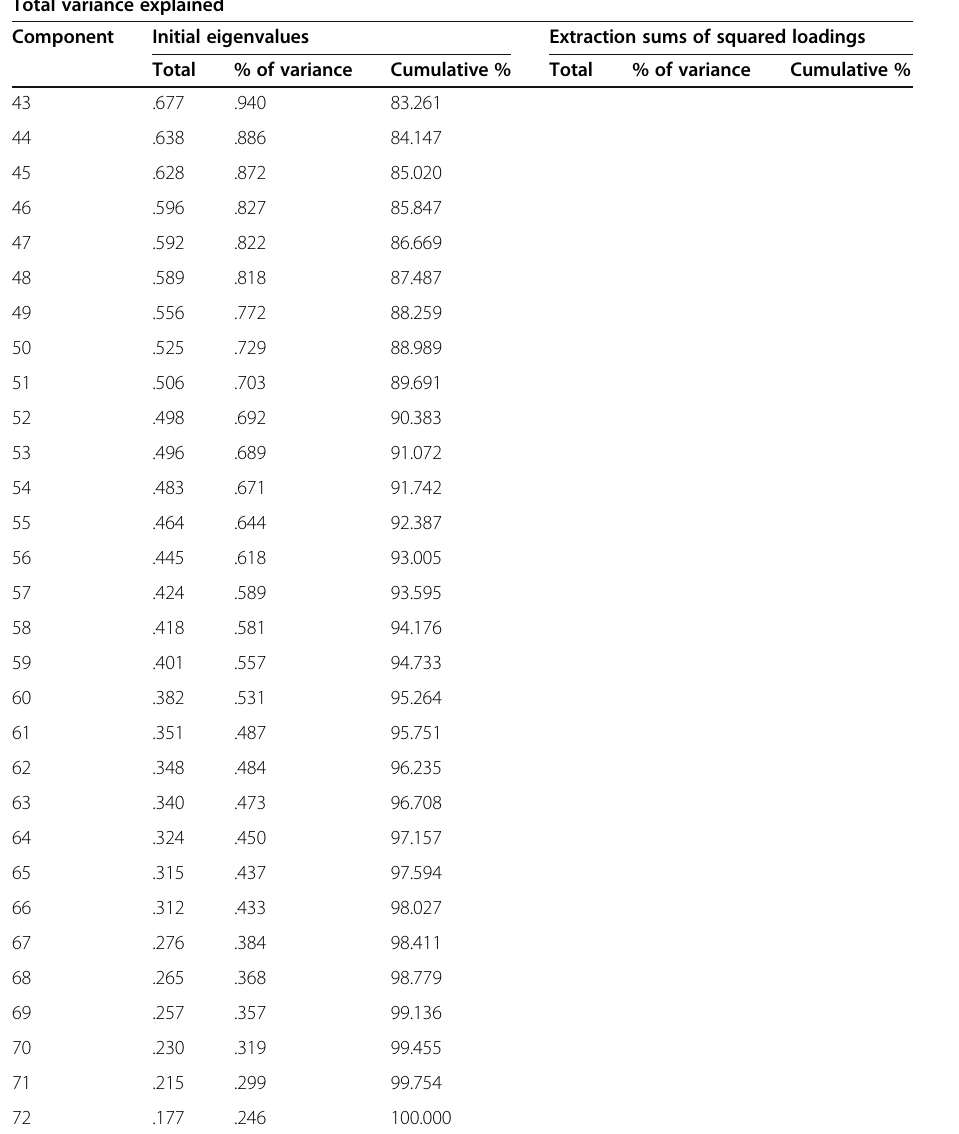
Table 7 Factor extraction total variance explained